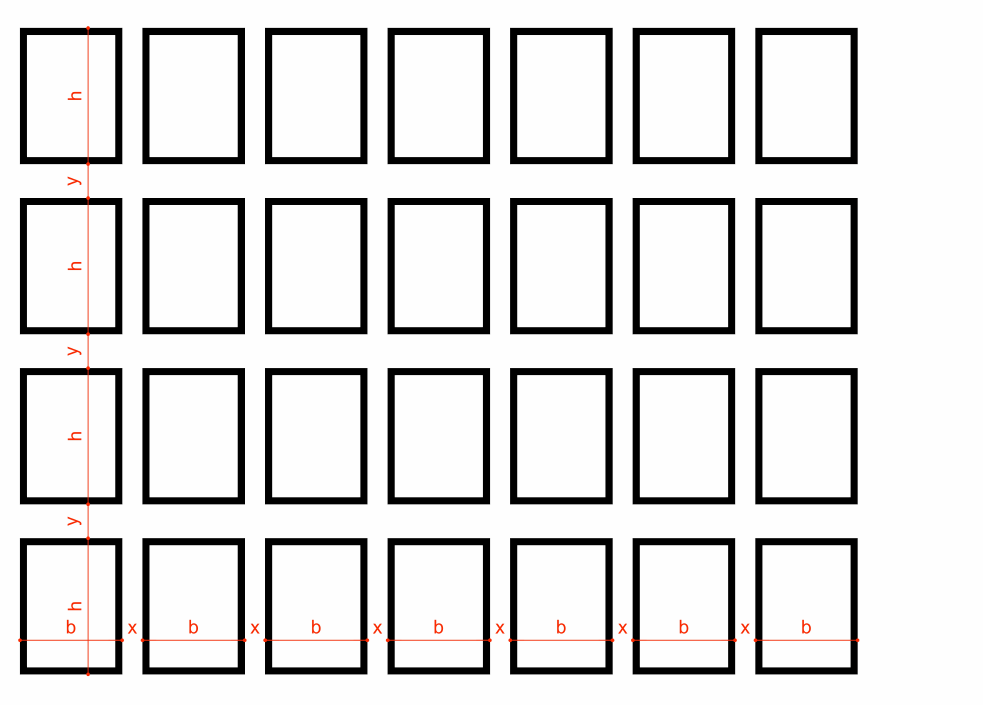
Figure 4. Diagram showing the assumptions of an “X” composition.